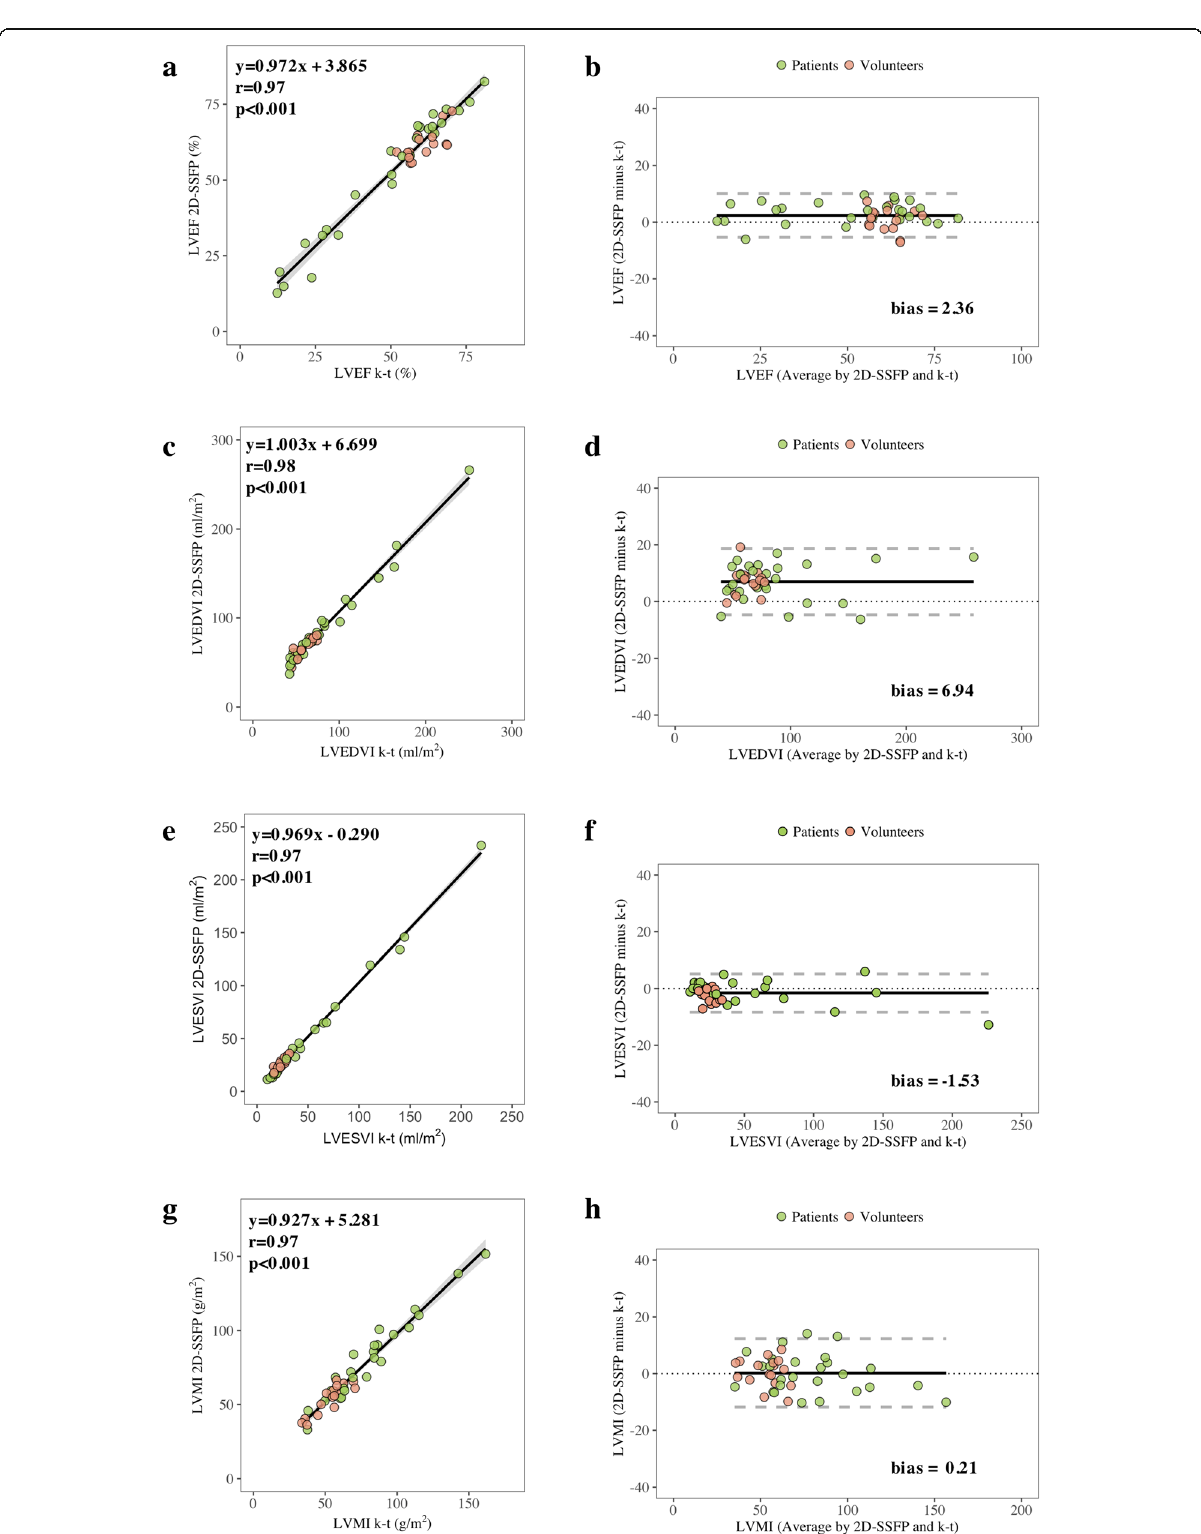
Fig. 2 LV volumes, function and mass by accelerated k-t SENSE and 2D-SSFP images. Correlations ( a , c , e , g ) and Bland-Altman analysis ( b , d , f , h ). LVEF left ventricular ejection fraction, LVEDVI left ventricular end-diastolic volume index, LVESVI left ventricular end-systolic volume index, LVMI left ventricular mass